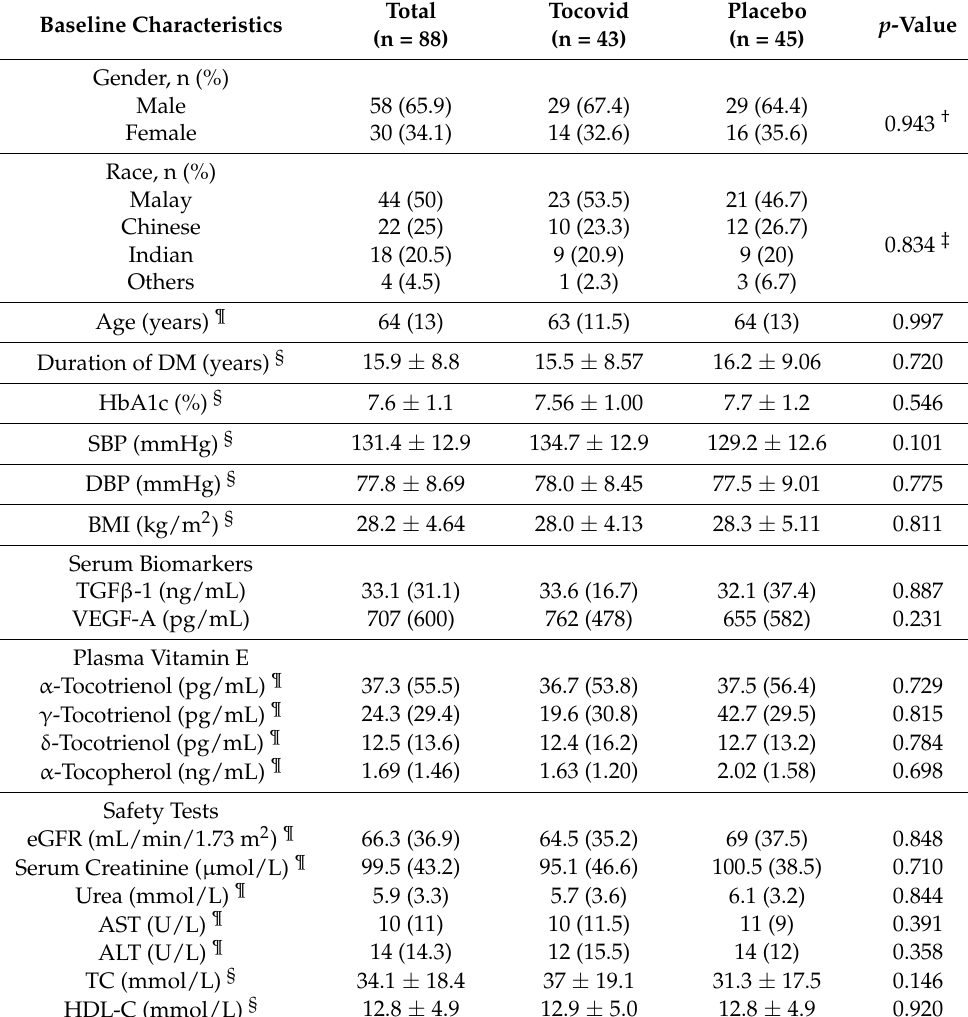
Table 1. Baseline characteristics of study